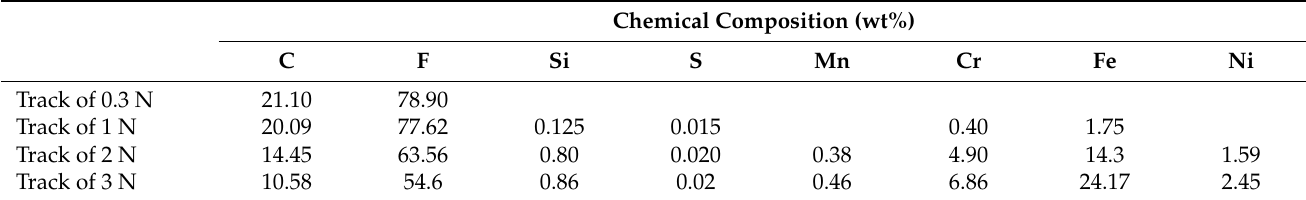
Table 2. Chemical composition of the film after and before wear tracks. Chemical Composition